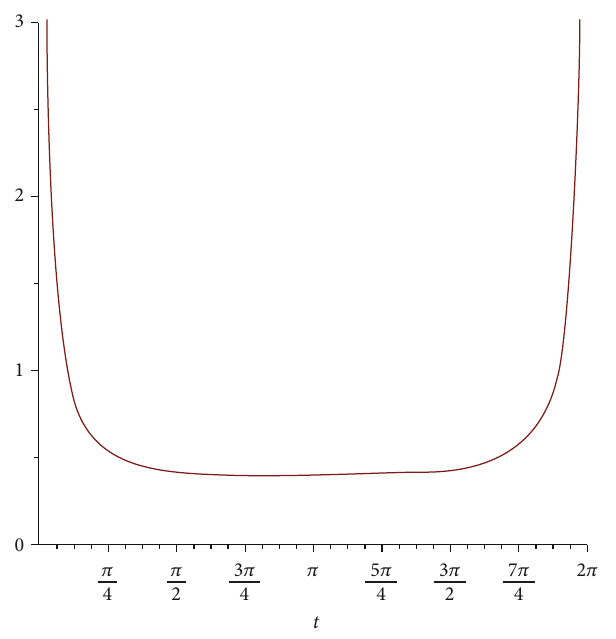
Figure 2: The plot of Ψ ð Re it Þ for t ∈ ½ 0, 2 π Þ and R = 1